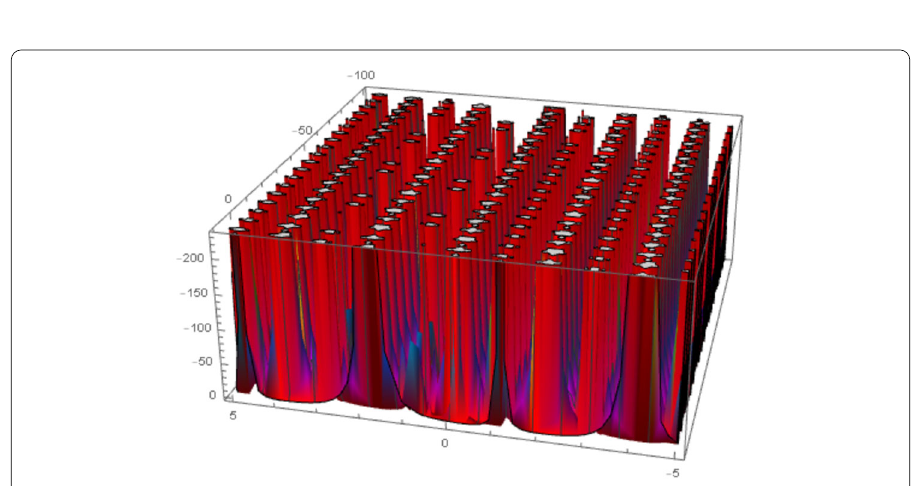
Figure 8 Periodic wave solution of u 12 ( η ) for α = 0.9, a 1 = 11, λ = –100, b 0 = 1, V = 10